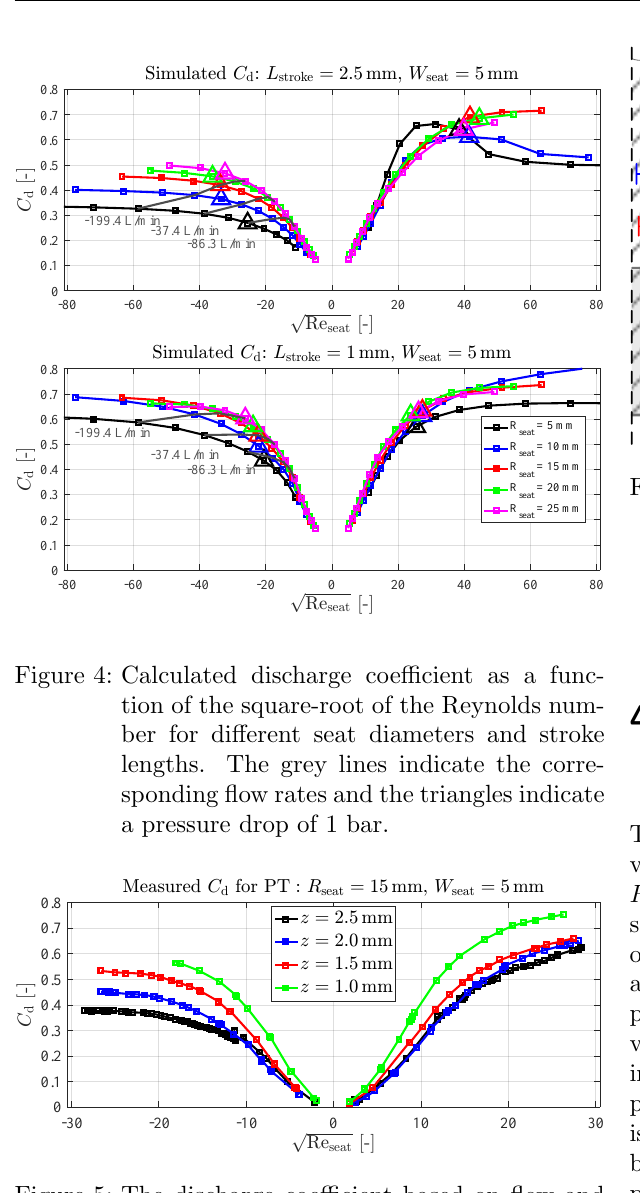
Figure 5: The discharge coefficient based on flow and pressure measurements on the active check- valve PT for different plunger positions.